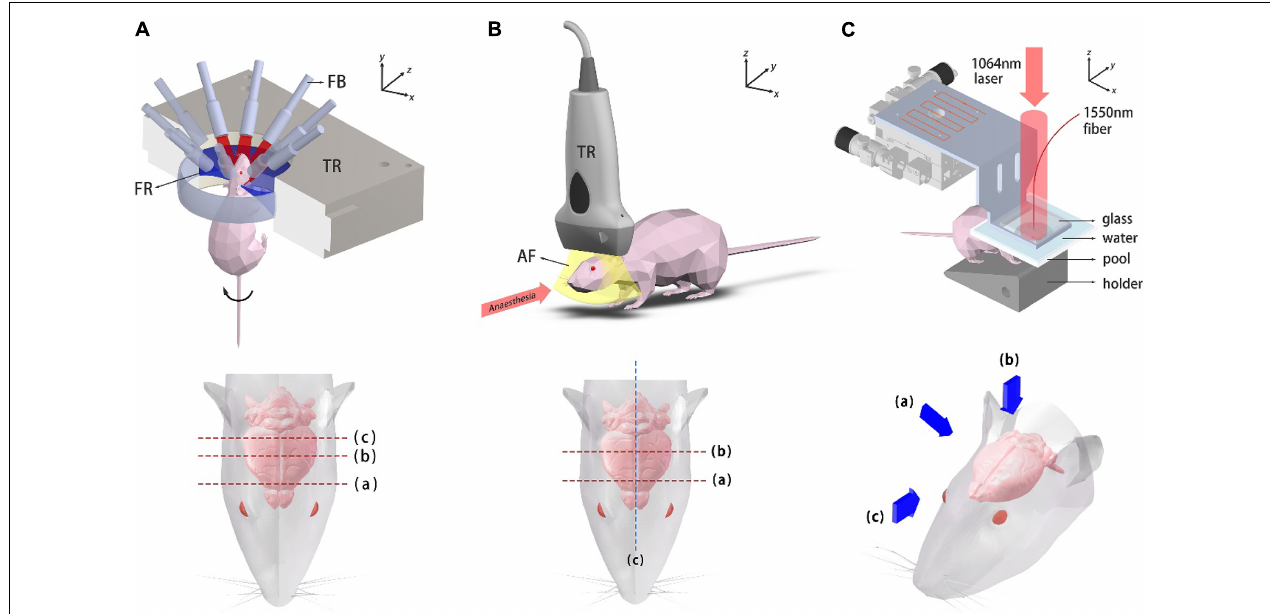
FIGURE 2 | Schematic diagrams of the imaging systems. (A) Ring-array PACT system and top view of the mouse head. Dashed lines label the imaged coronal plane positions. TR, transducer array; FB, fiber bundle; FR, focusing region. (B) System setup of the USI system and top view of the mouse head. Dashed lines label the imaged coronal plane positions. TR, transducer probe; AF, acoustic focal plane. (C) Photoacoustic mesoscopy system and three viewing perspectives, which are presented with blue